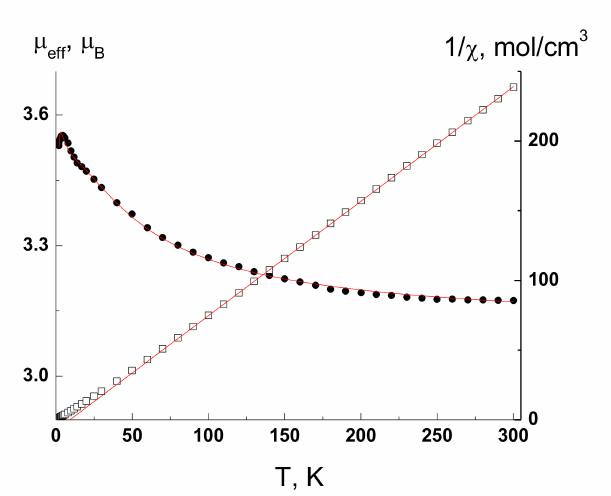
Figure 6. The µ e ff ( T ) ( • ) and 1 / χ ( T ) ( (cid:3) ) dependences for the [Cu(hfac) 2 ( 4 ) 2 ] complex (solid curves are theoretical